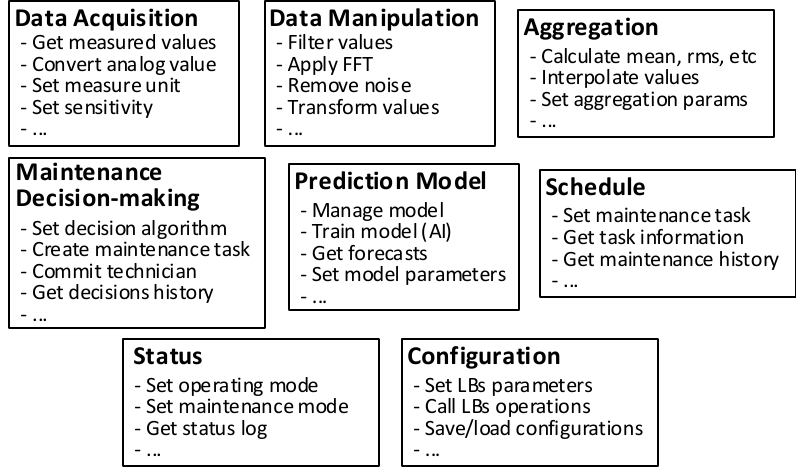
Figure 2. The logical blocks implementing generic functionalities related to predictive maintenance (PdM) aspects. FFT: fast Fourier transform; LB: logical block.